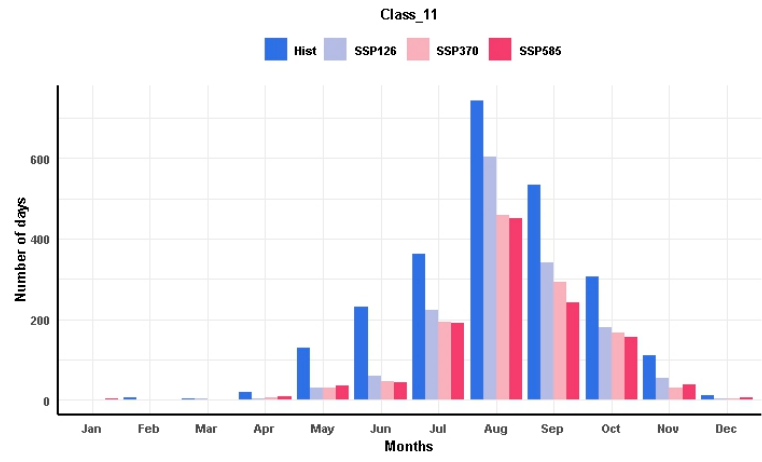
Figure 13. As in Figure 3 for CP11.